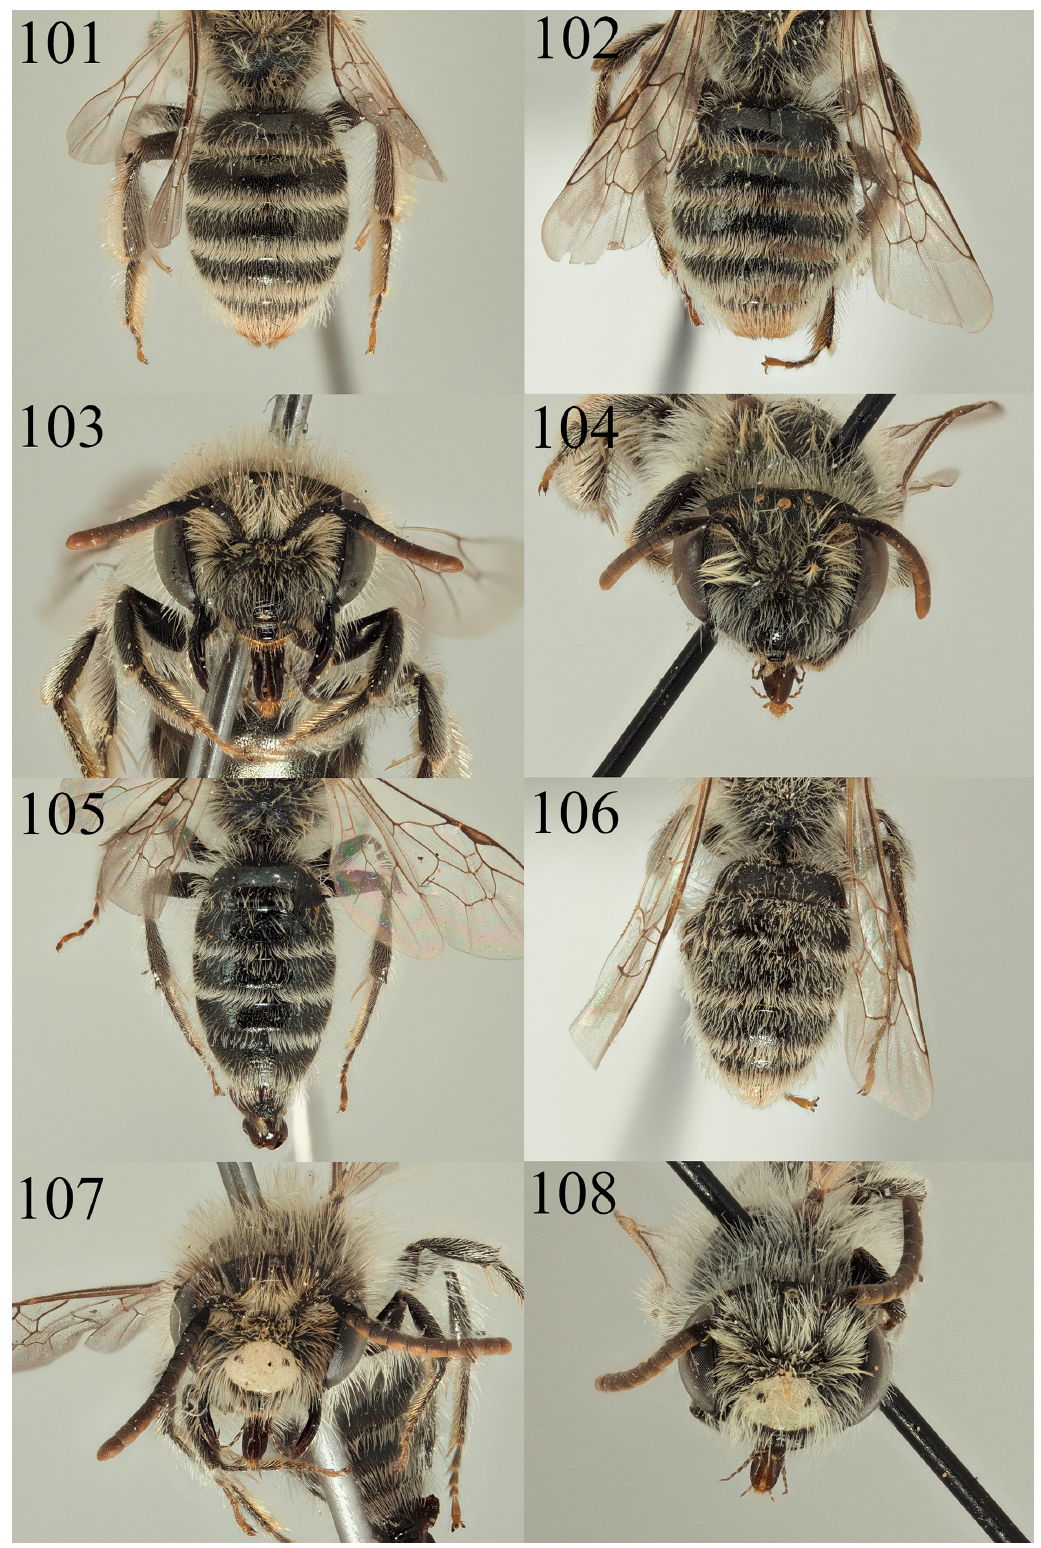
Figs 101–108. Andrena laurivora Warncke, 1974 (TJWC). 101, 103, 105, 107 . Spanish